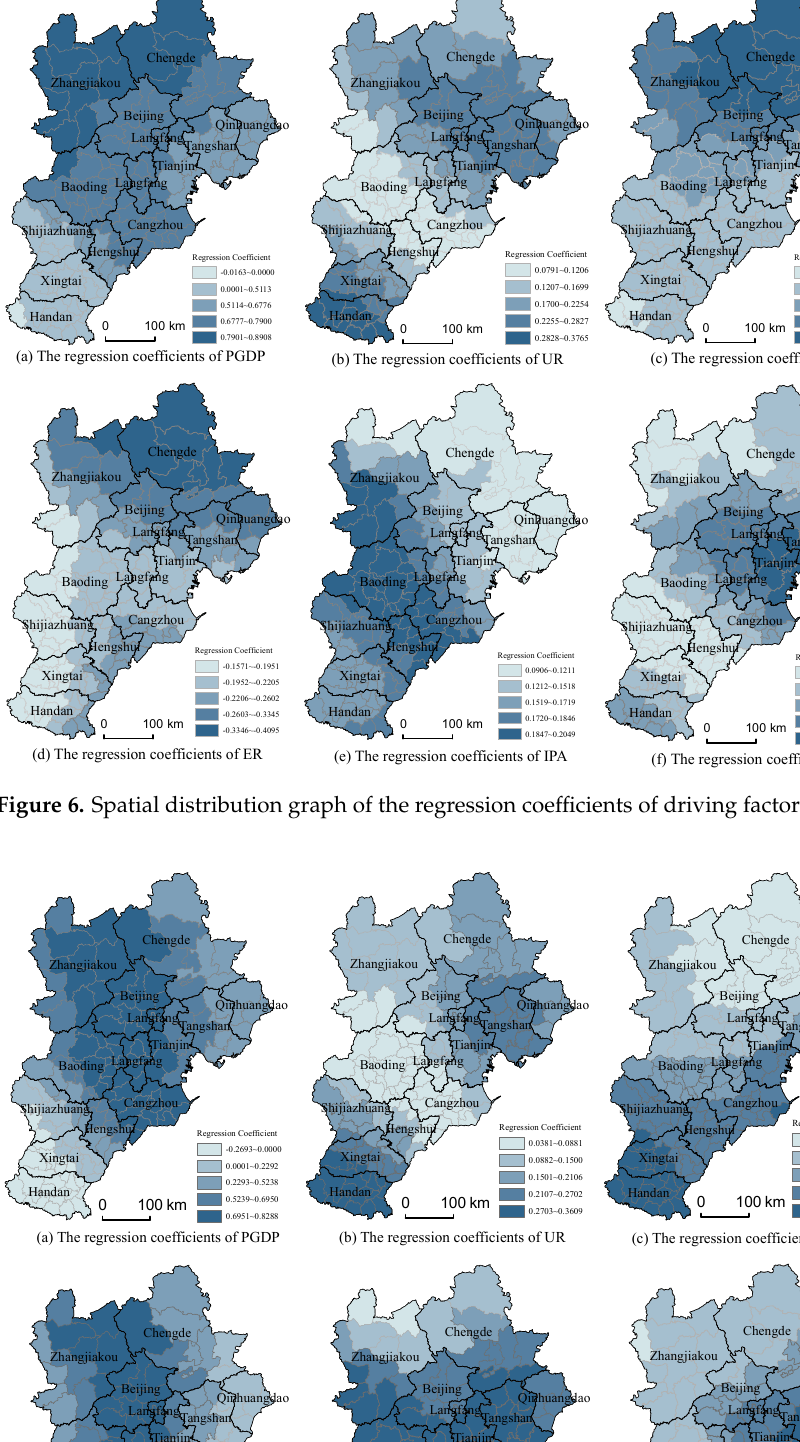
Figure 5. Center of gravity (CG) of water pollutants discharge in the Beijing–Tianjin–Hebei region and standard deviational ellipse (SDE).